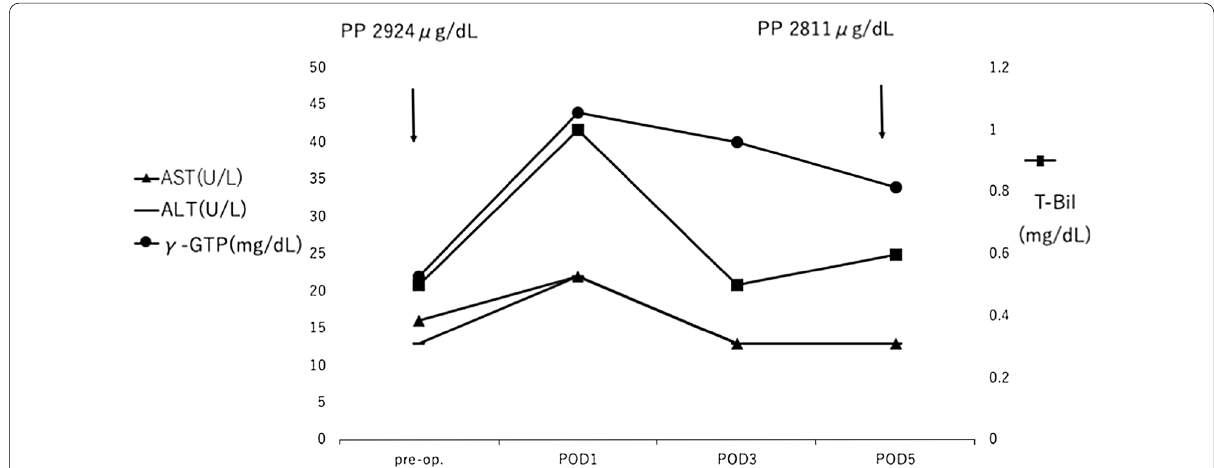
Fig. 3 Lab parameters showing stable liver function. The postoperative course was uneventful, and the level of PP and liver function were